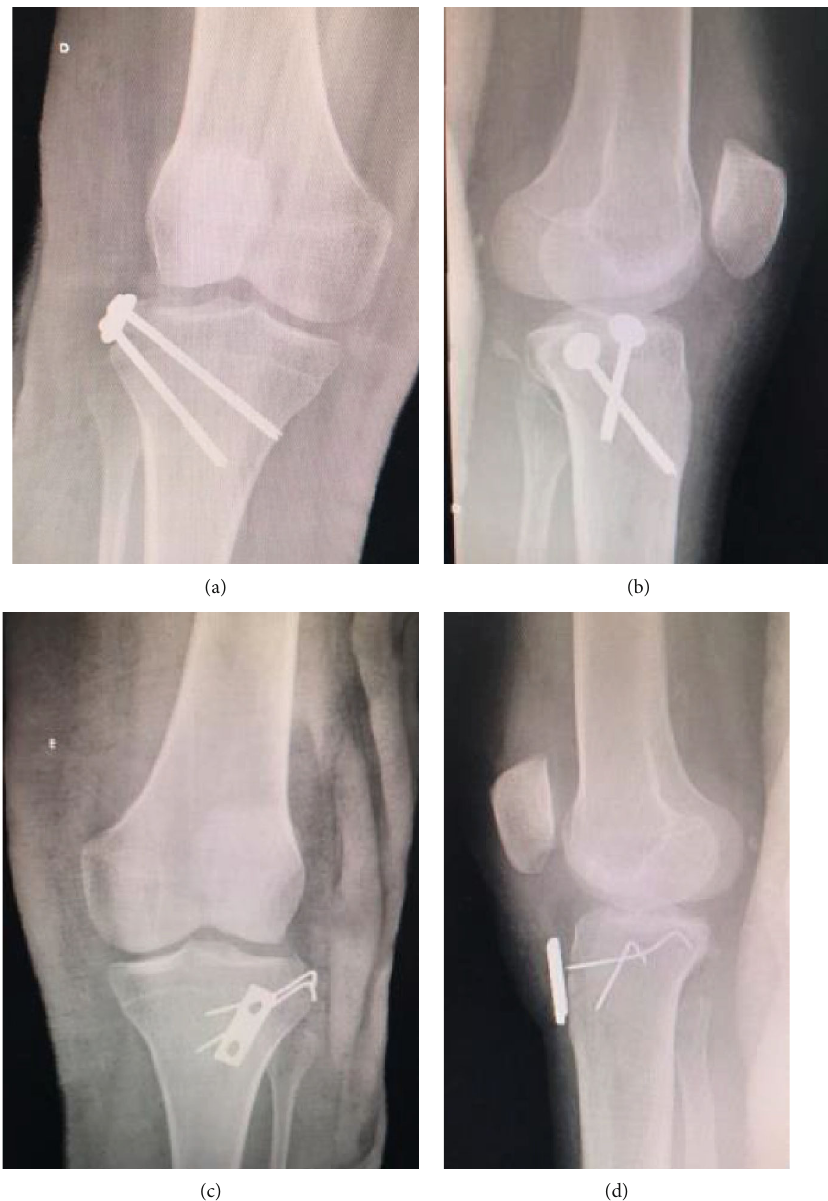
Figure 3: Anteroposterior radiographs pos operative and lateral view of the right knee (a, b) and left knee (c,